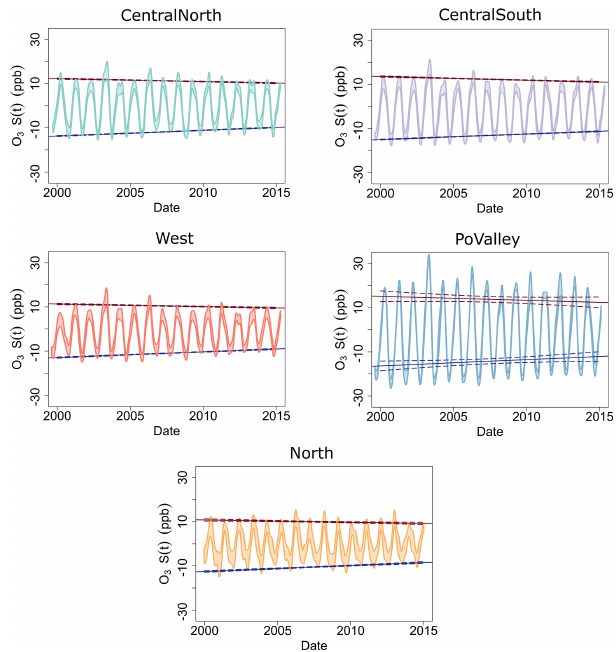
Figure 9. Temporal evolution of S max and S min for the daily mean O 3 S(t) clusters together with the average S(t) (bands indicate the average ± the standard deviation). Solid lines show the linear trends of S max and S min , and dashed lines show the 90% confidence inter- val.